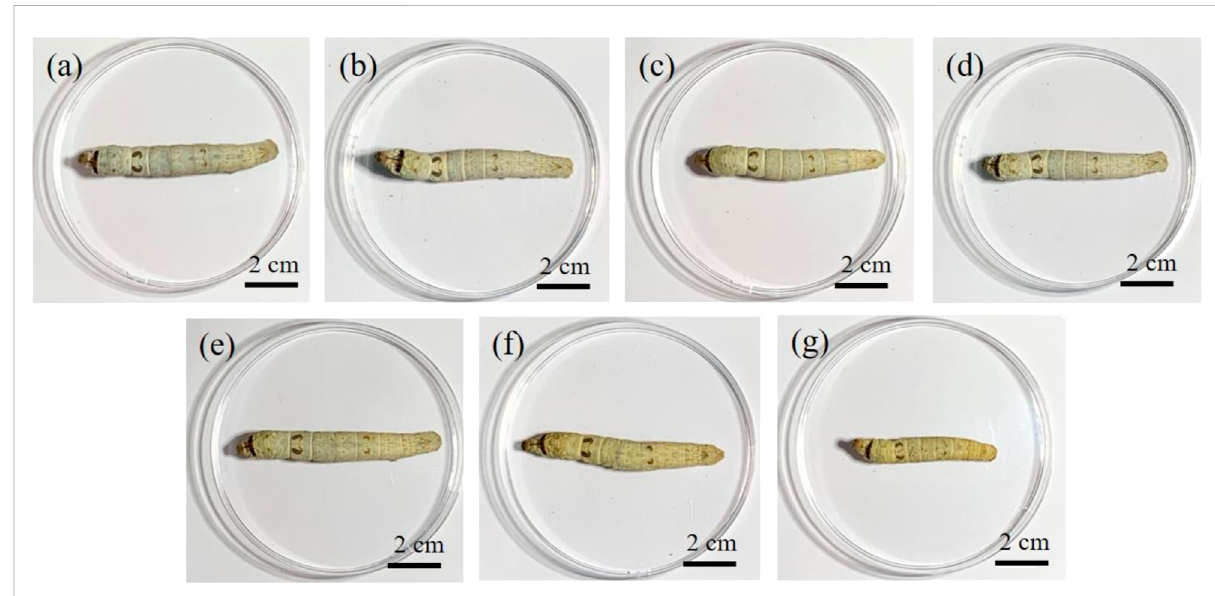
EffectofAMTfeedingontheappearanceofthesilkwormlarvae: (A) control group, (B) Mo-0.05 g/L group, (C) Mo-0.1 g/Lgroup, (D) Mo-0.5 g/ L group, (E) Mo-1 g/L group, (F) Mo-5 g/L group, and (G) Mo-10 g/L